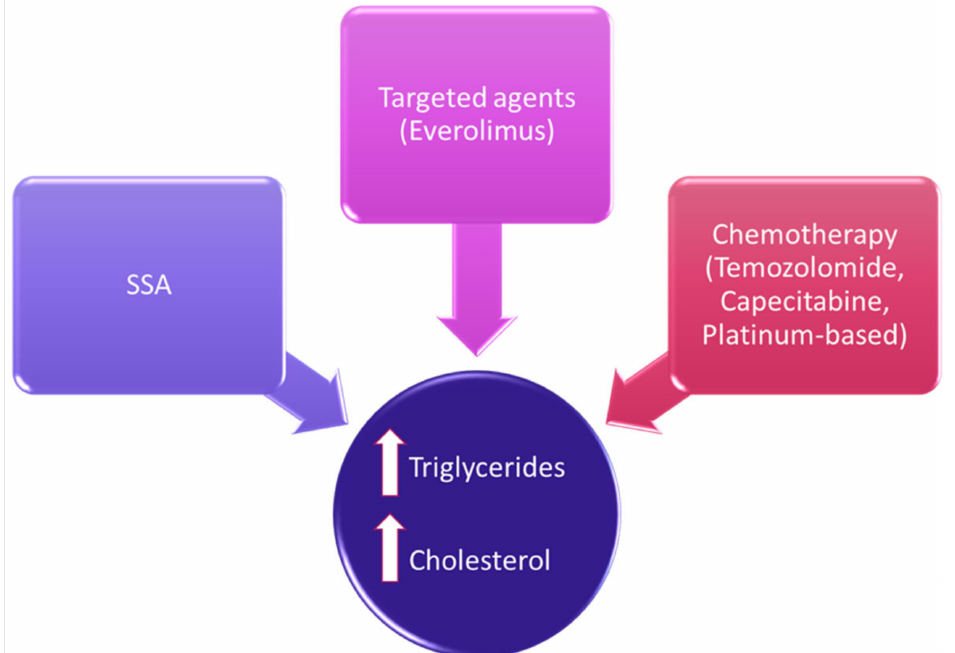
Figure 1. Treatment-related lipid alterations in